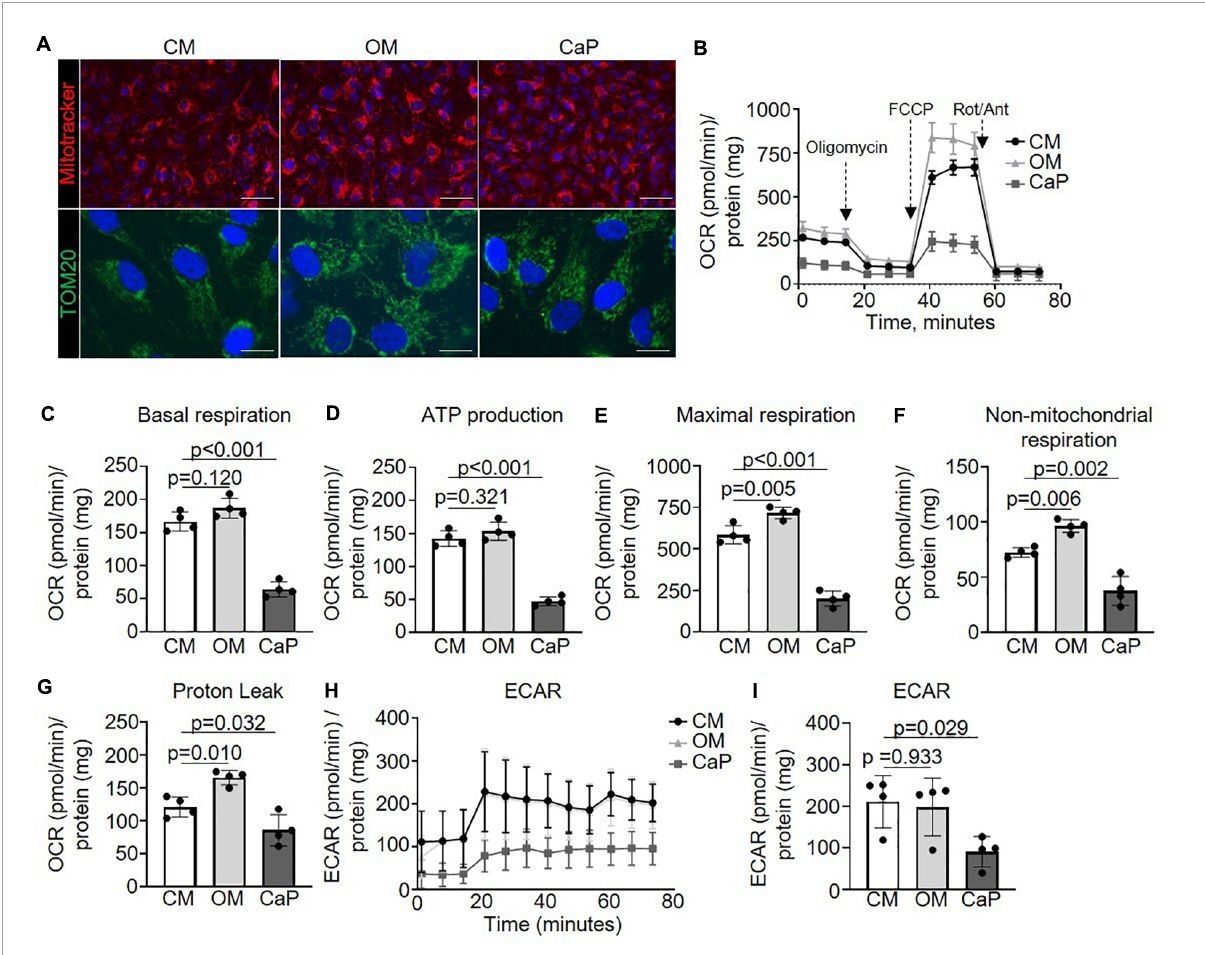
FIGURE3 Mitochondrial respiration increases in osteogenic medium (OM) and attenuates in calcium phosphate (CaP)-calcified vascular smooth muscle cells (SMC) Immortalized SMCs (iSMCs) were cultured for 7 days in control medium (CM), OM or CaP. (A) Representative images of live iSMCs for the mitochondria-specific dye MitoTracker Red (red) and nuclear Hoeschst staining (blue) and immunofluorescence for TOM20 (green) with DAPI nuclear staining (blue). n = 3, scale bar: 75 µ m and 10 µ m, respectively. (B) Mitochondrial oxygen consumption rates (OCR) of OM and CaP-calcified iSMCs subjected to the XF Mito Stress Test measured using the Seahorse XF96 flux analyzer, with sequential injections of mitochondrial effectors [oligomycin, carbonyl cyanide-4 (trifluoromethoxy) phenylhydrazone (FCCP) and rotenone (Rot), antimycin (Ant)] at time points indicated by the downward arrows. n = 4. (C) Basal respiration, (D) ATP production. (E) Maximal respiration. (F) Non-mitochondrial respiration. (G) Proton leak. (H,I) Extracellular acidification rate (ECAR) and quantification. OCR and ECAR were normalized to protein content. Error bars indicate ± SD. Each n indicates an independent replicate. One-way ANOVA with Dunnet’s post hoc